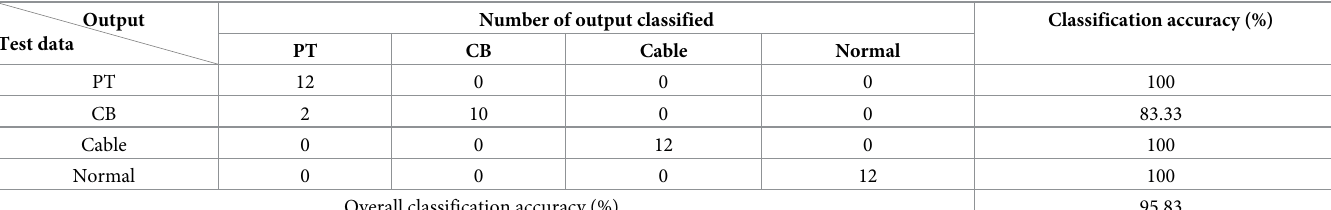
Table 7. Classification results using GSA-SVM based on 70:30 ratio for training and testing data.